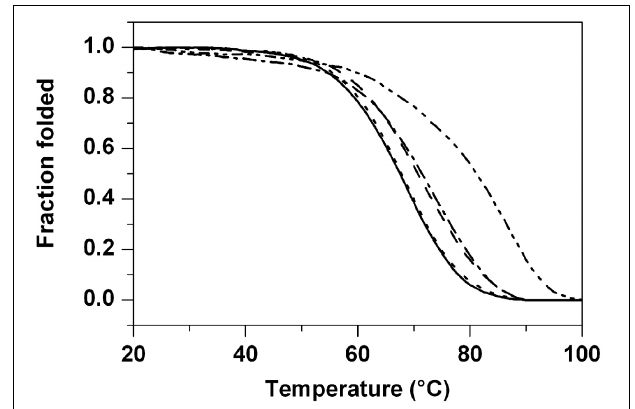
FIGURE 3 | CD melting experiments. Normalized CD melting curves of tel23-p in the absence (solid) and in presence of 4 molar equiv of ligands